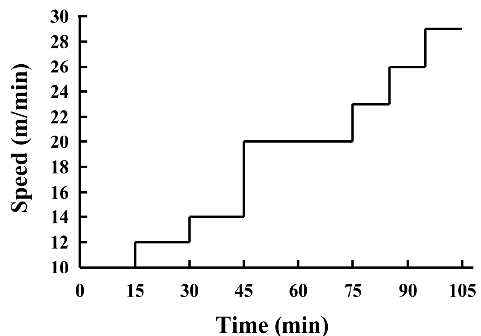
Figure 2. The protocol of the exhaustive treadmill test.